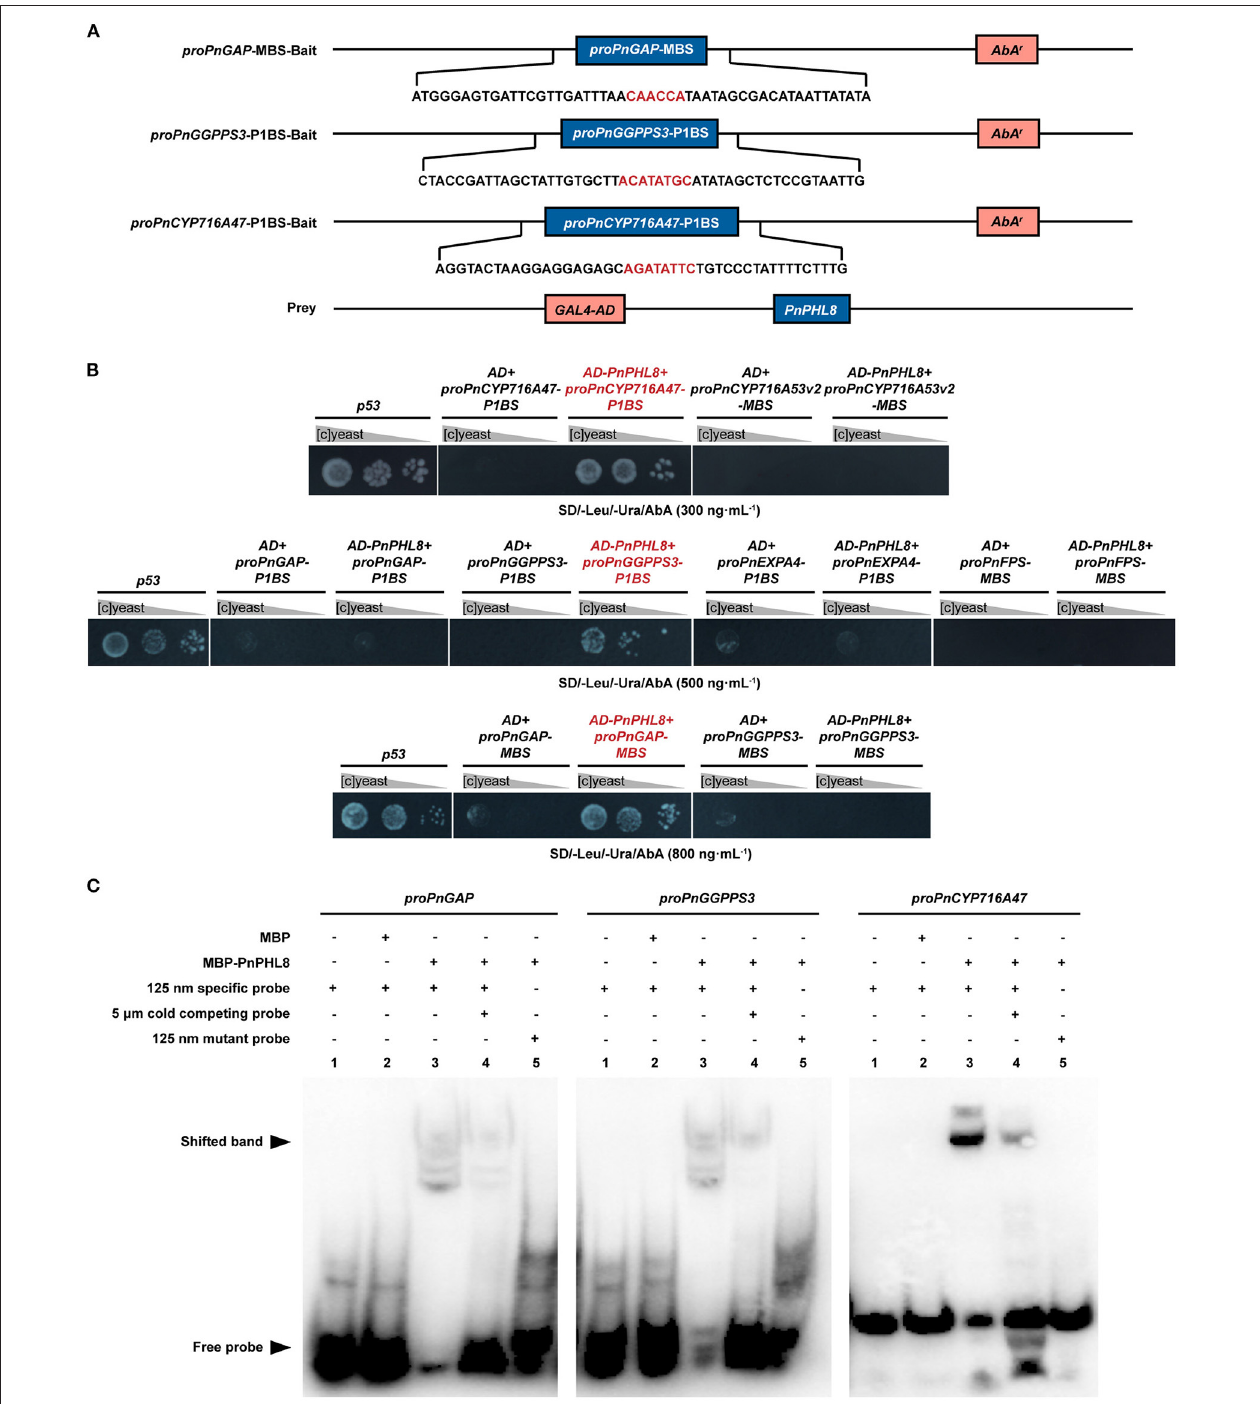
FIGURE 5 | PnPHL8 binds with the promoter sequence of PnGAP , PnCYP716A47, and PnGGPPS3 . (A) Structural schematics of baits and prey in yeast one-hybrid (Y1H) assay. (B) Y1H assay between PnPHL8 and PIBS domains as well as MBS domains of proPnGAP (promoter of PnGAP ), proPnEXPA4 (promoter of PnEXPA4 ), proPnGGPPS3 (promoter of PnGGPPS3 ), proPnCYP716A47 (promoter of PnCYP716A47 ), proPnCYP716A53v2 (promotor of PnCYP716A53v2 ), and proPnFPS (promotor of PnFPS ). Gray triangles represent dilution factor of the yeast concentration, while p53 served as a positive control. (C) EMSA among PnPHL8, proPnGAP , proPnCYP716A47 , and proPnGGPPS3 . GAP, glycosylphosphatidylinositol-anchored protein; PHL, phosphate starvation response transcription factor like; AbA, aureobasidin.